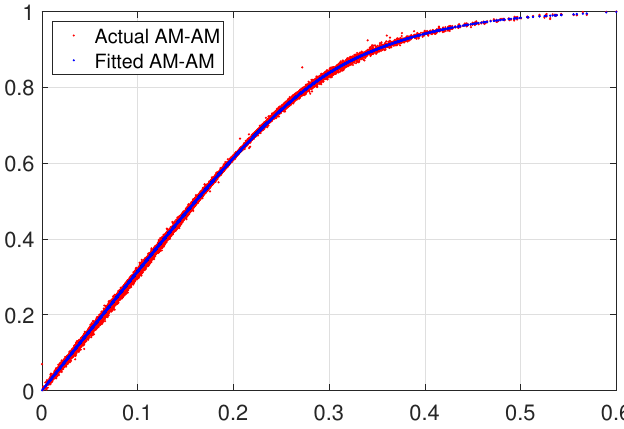
Figure 6. Approximation for a fitted model with polynomial basis.